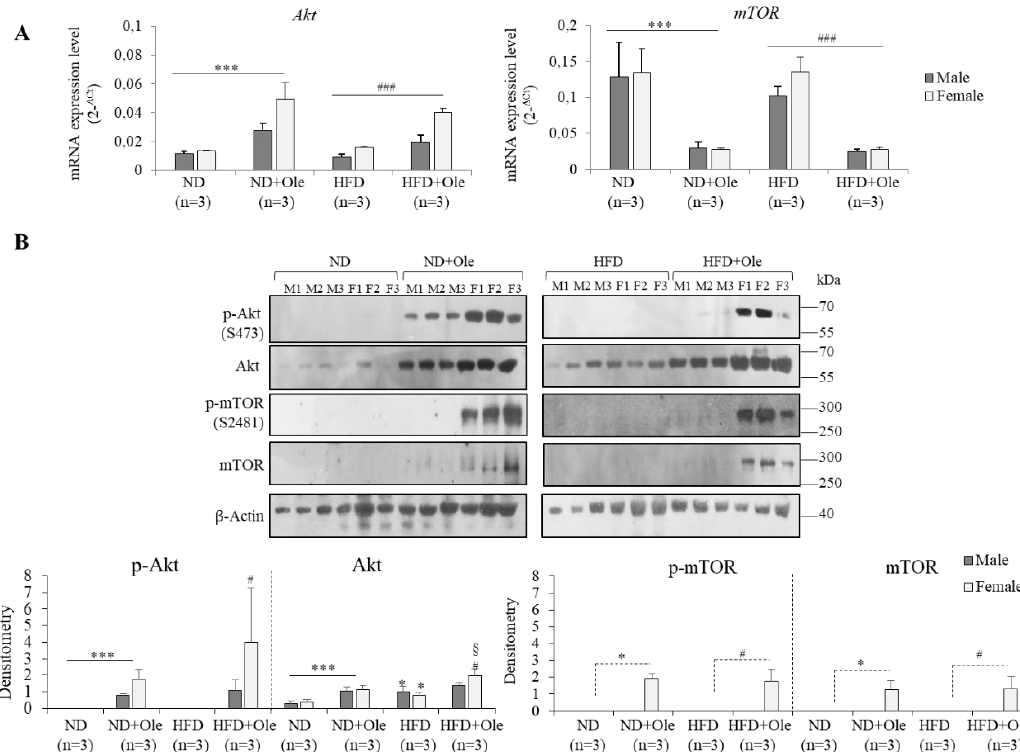
Figure 2. Gender-specific Akt/mTOR pathway in ND and HFD mice before and after Ole treatment. ( A ) Akt and mTOR mRNA expression level evaluated by Q-PCR in ND, ND + Ole, HFD and HFD + Ole male and female mice. Gene expression values are expressed as 2 − ∆ C t values. The results are reported as mean ± SD. ( B ) Western blot analysis and relative densitometry of total and phosphorylated (p-Akt (S473), p-mTOR (S2481)) proteins in ND and HFD male (M) and female (F) mice, treated or not with Ole. Values are expressed as fold mean ± SD. * p < 0.05, *** p < 0.001 vs. ND; # p < 0.05, ### p < 0.001 vs. HFD; § p < 0.05 vs. ND + Ole.